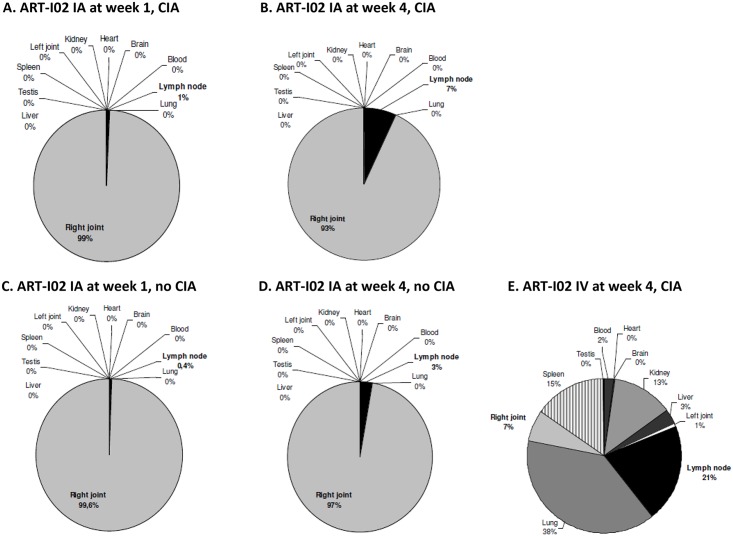
Vector biodistribution of ART-I02 in arthritic animals.Vectors were injected intra-articularly (IA) on day 14 after arthritis induction and vector DNA biodistribution was determined 1 and 4 weeks after administration by RT-PCR of a number of tissues (injected joint (right), non-injected joint (left), draining lymphnode, liver, lung, heart, testis, kidney, brain, spleen and blood) (N = 6 per group). Minimal vector spreading outside the joints was detected 1 and 4 weeks after intra-articular administration in animals with (A and B respectively) and without arthritis (C and D respectively). A different pattern was observed after intravenous (IV) administration of the vector, with almost 40% detected in the lungs (E). Data are shown as percentages of the total amount of vector retrieved. CIA, collagen induced arthritis.